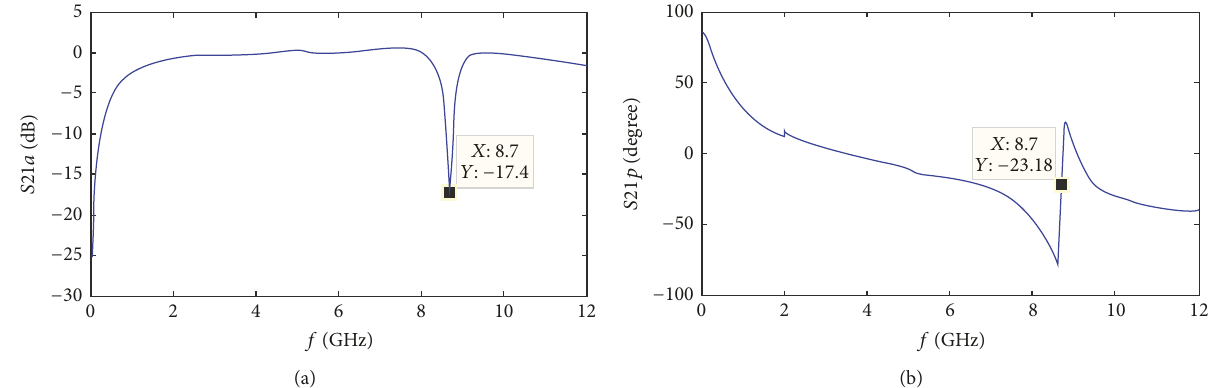
Figure 11: The measured S -parameters of the 2.0 pF capacitor: (a) magnitude and (b) phase.